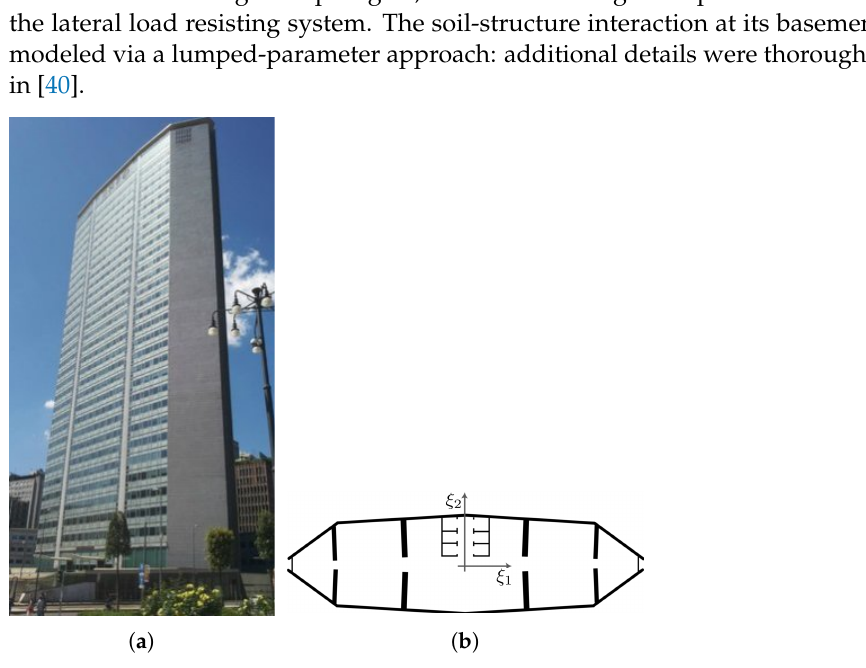
Figure 22. The Pirelli Tower in Milan. ( a ) Picture taken from Piazza Duca D’Aosta, and ( b ) schematic plan of a standard